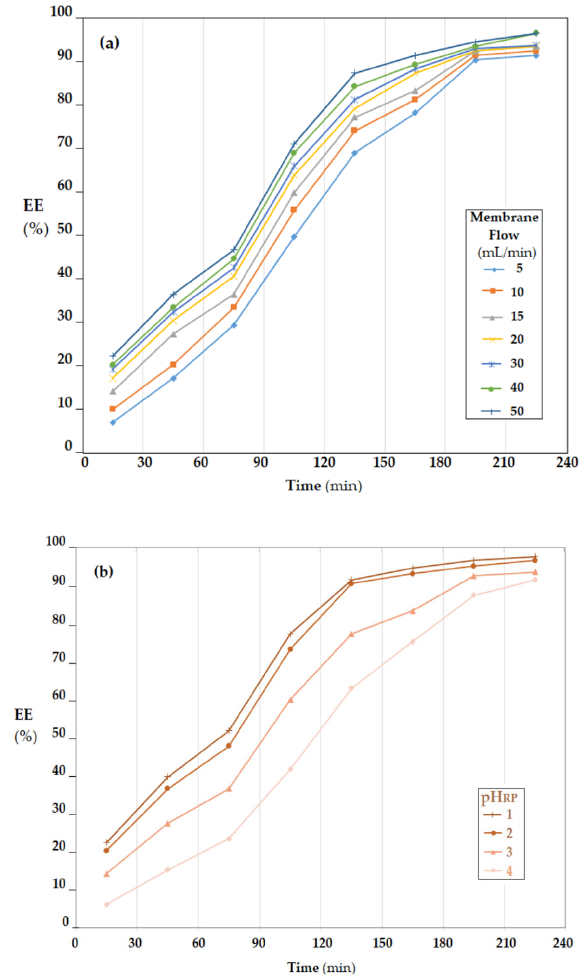
Figure 14. Extraction efficiency (EE) of p -nitrophenol ( p NP) depending on: ( a ) the membrane flow through the receiving phase; and ( b ) pH of the receiving phase.